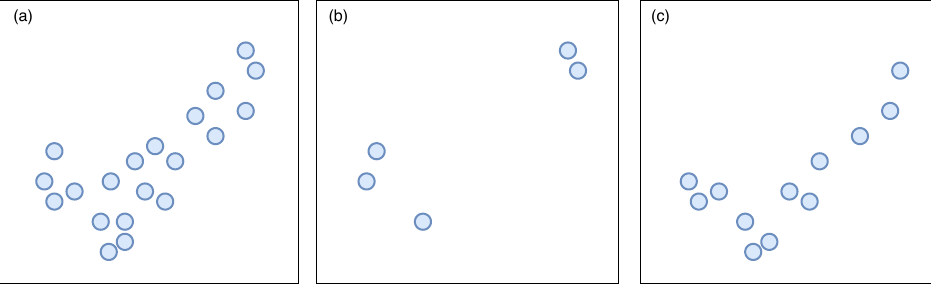
Figure 3. ( a ) Dominant Scattering Area of the target, ( b ) true class residues and ( c ) false class residues. Fan and Thomas [35] created masks by drawing circles centered on each scattering center of the target under test. The masks were then used by the Neighbor Matching Algorithm (NMA) to filter the scattering centers of each model class. This last approach, illustrated in Figure 4, was implemented for comparison purposes with the proposed algorithm, and the results are presented in Section 3.3.